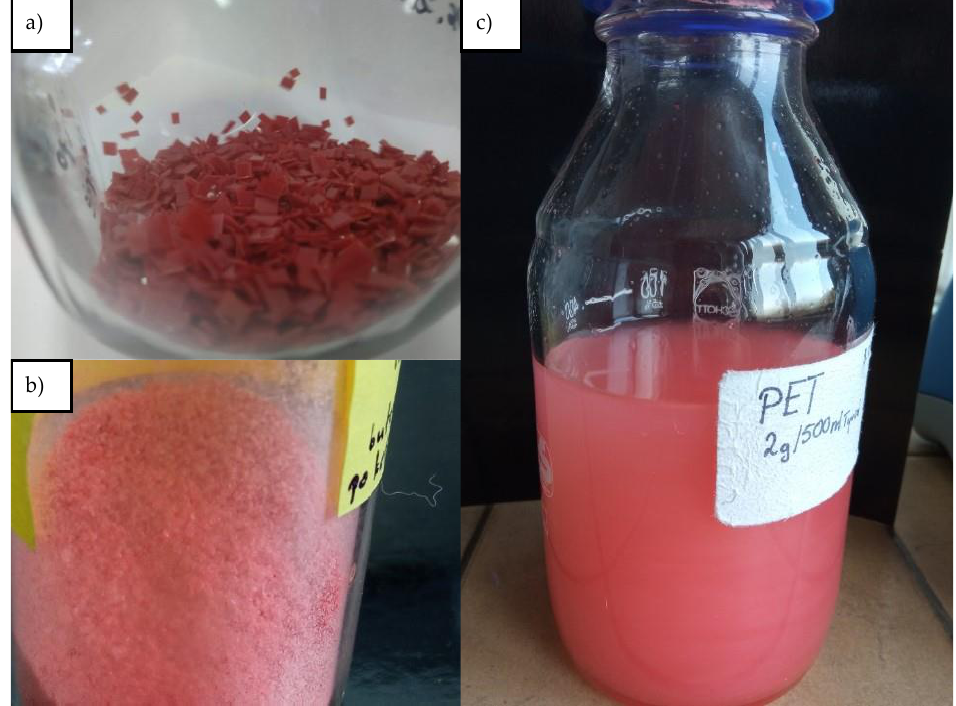
Figure 1. Prepared samples of microplastics. ( a ) cut plastic ketchup bottle made of PET; ( b ) milled and sieved microparticles; ( c ) stock suspension of the microplastics.